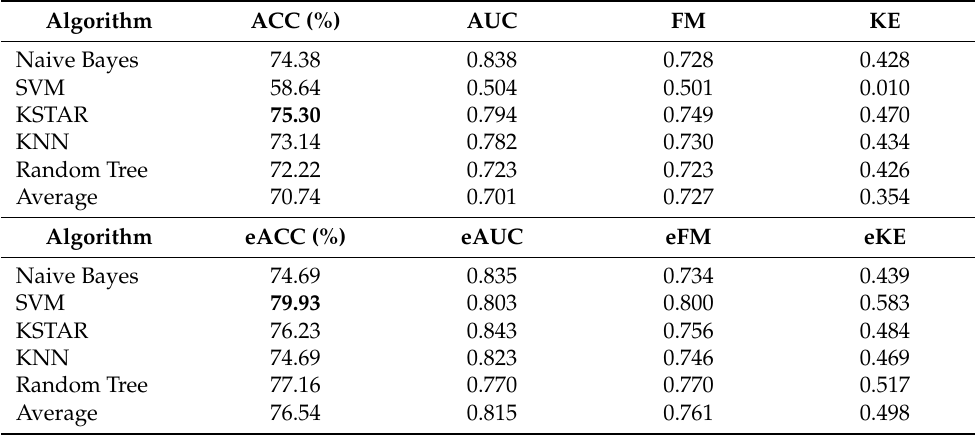
Table 8. Classification results for Eclipse data